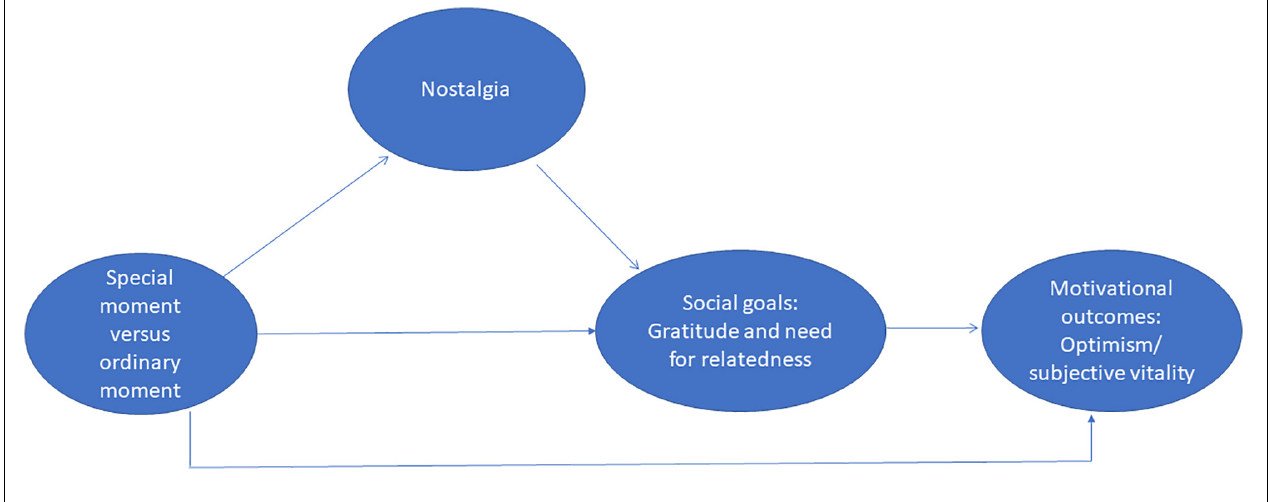
FIGURE 1 | Conceptual